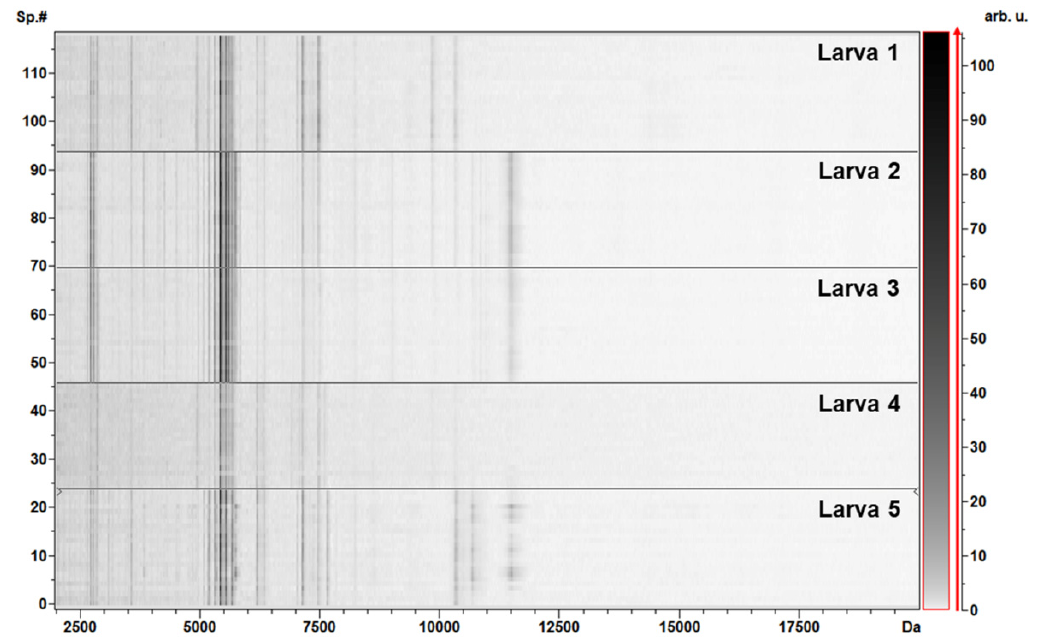
Figure 3. Pseudogel view of the five larvae (samples B M ) from MALDI–TOF MS profiling. The mass- to-charge values ( m/z , Da) are reported on the x-axis, while the gray scale bar, reported on the right y-axis, shows the relationship between the color intensity and the peak intensity, expressed by arbitrary units (arb. u.). The left y-axis evidences the spectra numbers (Sp.#).